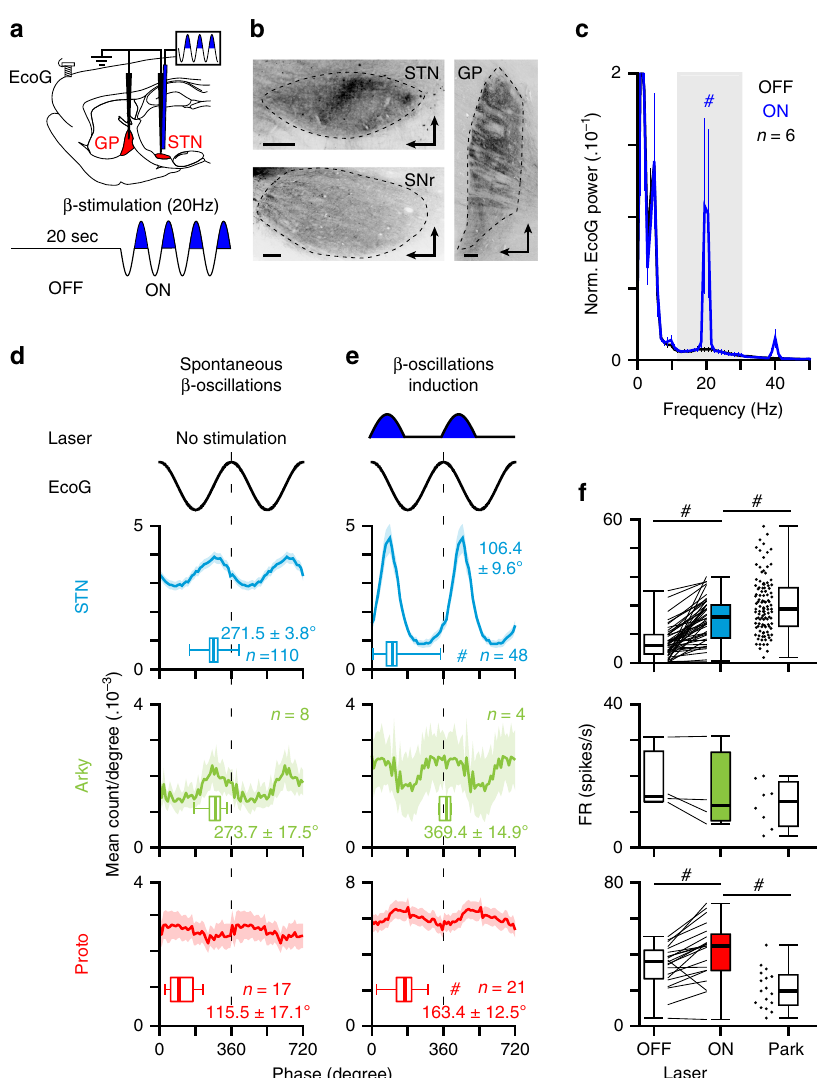
Fig. 3 Excitatory optogenetic patterning of STN neurons at β -frequency does not replicate the functional properties of parkinsonian β - oscillations. a Schematic of the experiment in ChR2-expressing STN neurons (top) and laser stimulation protocol (bottom) used to mimic abnormal β -oscillations in normal rats. b Sagittal epi fl uorescence images showing the ChR2-EYFP labeling at the level of the STN (top left) and their axons in SNr (bottom left) and GP (right) (scale: 200 µ m). Slices orientation: dorso-rostral. c Mean power spectrum of mCx ECoG during OFF and ON laser stimulation in normal rat. d Mean phase histograms of STN (top), arkypallidal (middle), and prototypic (bottom) neurons during abnormal β -oscillations recorded in 6-OHDA- lesioned rats. e Mean phase histograms of STN (top), arkypallidal (middle), and prototypic (bottom) neurons during synthetic β -oscillations evoked via opto-patterning of STN neurons using ChR2 in control rats. f Comparison of the change in fi ring rate induced by synthetic β as compared with abnormal parkinsonian β in STN, arkypallidal, and prototypic neurons. Group data represents mean ± SEM, box-and-whisker plots indicate median, fi rst and third quartile, min, and max values. See also Supplementary Table 3 for statistical with unit activity recordings of the two main population of GP decrease fi ring of prototypic neurons). Importantly, these fi ne neurons (i.e., the prototypic and arkypallidal cells) also reveal that STN/GP spike-timing features during PD β -oscillations were synthetic β -oscillations could propagate to GP neurons and cause con fi rmed in our dataset (Fig. 3d). On the contrary, arti fi cial a signi fi cant increase in the temporal coupling (measured through ChR2-induced β -oscillations did not reproduce any of the correct coherence analysis) between cortex and the two populations of STN/GP phase-locking preferences (Fig. 3e and Supplementary GP neurons (Supplementary Fig. 6a, b). We next assessed if our Table 3) while ArchT-induced β -oscillations reproduced the synthetic β -synchronization shared the same or as many as correct phase-locking value of STN neurons but not the one of possible functional properties as parkinsonian β -oscillations. In GP (Supplementary Fig. 5f). Importantly, both these arti fi cial β - particular, we focused our analysis on the known STN/GP neu- oscillations did not replicate the stereotypical antiphase fi ring rons spike-timing properties during these oscillations (that is the relationship between STN and prototypic GP neurons (Fig. 3d antiphase relationship between STN/prototypic and prototypic/ and Supplementary Fig. 5f, g). Instead, we found that the phase arkypallidal neurons, as well as the in-phase relationship between lags between STN and prototypic neurons (~57° for ChR2, Fig. 3e STN/arkypallidal neurons 24,25 ) and the associated fi ring rate versus ~42° for ArchT, Supplementary Fig. 5g) represent a time changes (that is the hyperactivity of STN neurons versus the delay of 7.9 and 5.8 ms, respectively, compatible with a